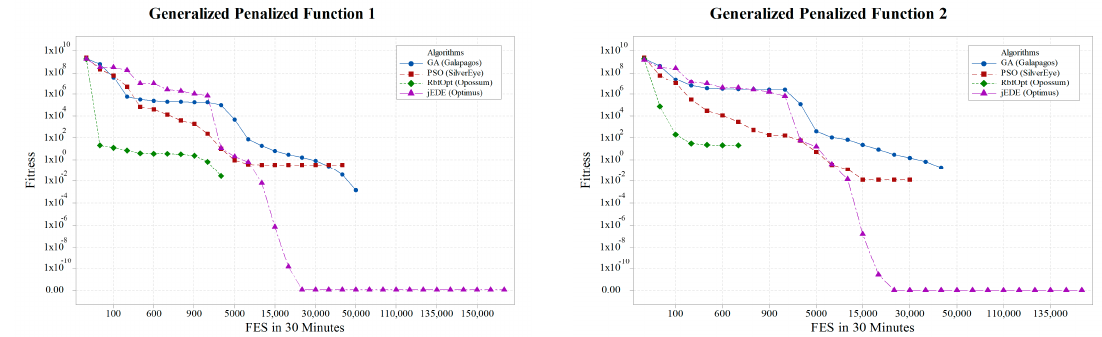
Figure 8. Convergence graphs of standard benchmark functions.